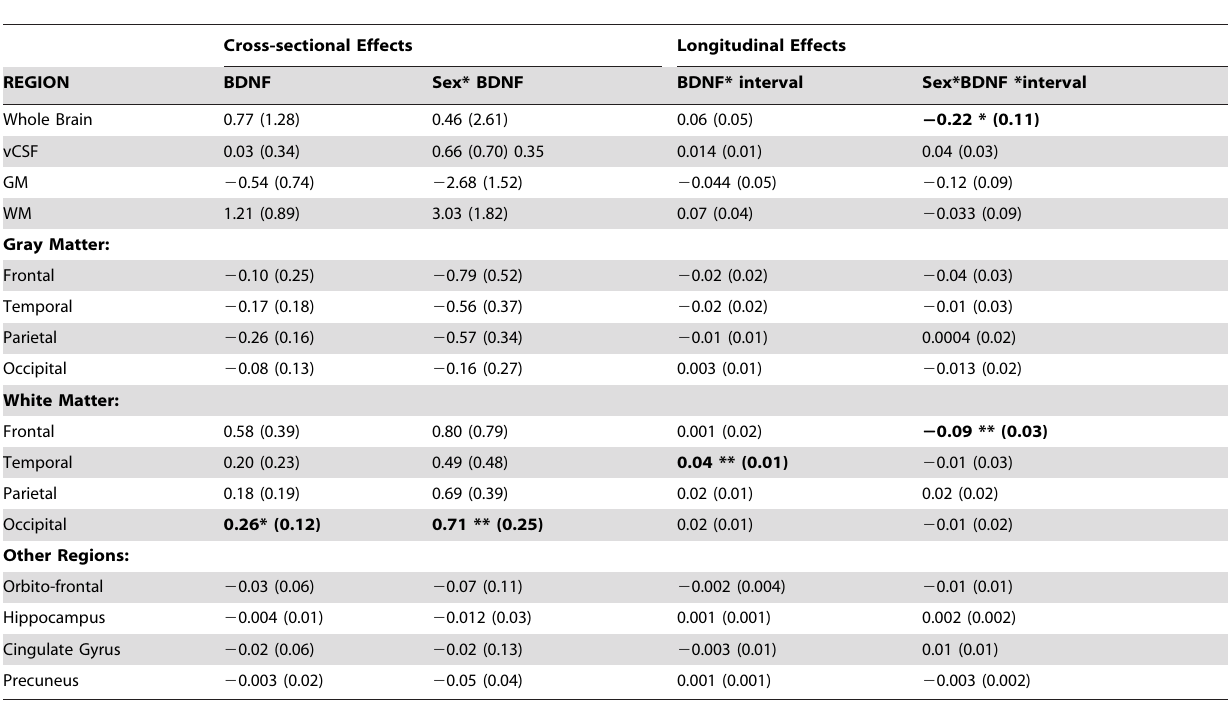
Table 2. Cross-sectional (main) effects of BDNF on regional brain volume and longitudinal brain volume changes (annual rates in cm 3 ) in relation to plasma